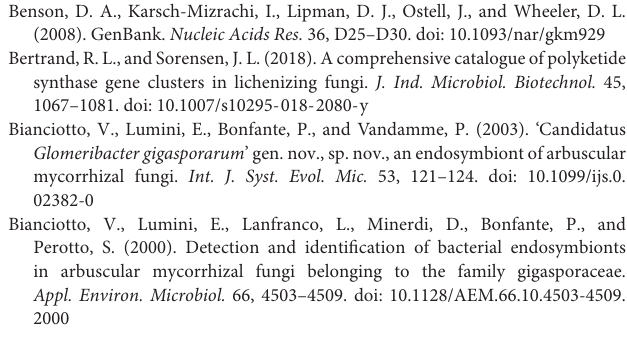
Supplementary Figure 2 | Prediction of putative BGC in G. margarita through co-expression analysis. Panels (A,B) represent the top 15 and 40 co-regulated genes, respectively, extracted from larger clusters of co-expressed genes calculated out of 24 RNA-seq libraries from different fungal life stages. Both networks contain genes with a calculated co-regulation coefficient > 0.6 in a range from 0 (no correlation) to 1 (full correlation). Co-regulation is shown as interconnections between nodes (genes), revealing that each gene is interconnected with all the others in the networks. (A) contains two putatively co-regulated PKS genes, while (B) contains a hybrid NRPS-PKS. Both networks contain other genes that may be associated with secondary metabolites biosynthesis and transport, such as P450 monooxygenases and general substrate transporters. Gene annotations were retrieved from Venice et al. (2020). Supplementary Figure 3 | ML tree based on the A domain of KAF0502938.1, a hybrid NRPS-PKS of G. margarita. The sequence of G. margarita , as well as that of its endobacterium, Ca Gg, are highlighted. Differently from the KS domain ( Figure 3 ), a clustering of Gigaspora sequences in a bacterial clade is not observed in the A tree. The sequence of the Ca Gg endobacterium clusters into a sub-clade which is well separated from the Gigaspora sequences, but which contains sequences from Myxococcus . Bootstrap support values are shown on the tree nodes. Thick lines indicate Bayesian posterior probability ≥ 95%. Supplementary Figure 4 | Phylogenetic reconstruction of LSU rRNA sequences from Gigasporales isolates. Isolates which were analyzed for the presence on NRPS-PKS in the present study are shown in bold. The tree shows the topology obtained with the Bayesian method; branches with Bayesian posterior probabilities ≥ 0.95 are thickened and ML bootstrap support values ≥ 70 are shown. The tree was rooted by Pacispora scintillans . Supplementary Table 1 | List of the RNA-seq libraries used for the co-expression analysis, and the related publications/projects. Supplementary Table 2 | List of BLAST homologs of G. margarita NRPS-PKS, KAF0502938.1, sorted by E -value. Except for hits from the closest sequenced relative, G. rosea , the list is dominated by bacterial homologs. Supplementary File 1 | List of topologies obtained for the KS domain of KAF0502938.1 by using different constraint analyses in RAxML. To confirm the bacterial signature of the domain, the unconstrained (A) topology was compared with other constrained topologies where Gigaspora species and bacteria (B)